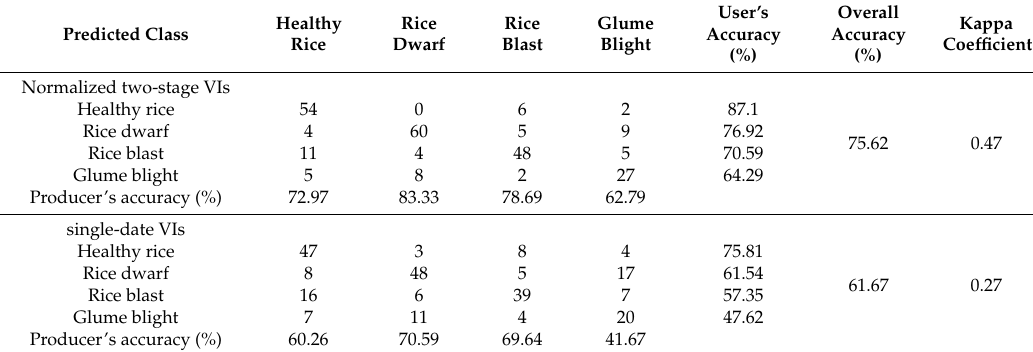
Table 5. The confusion matrices and classification accuracies produced by normalized two-stage VIs and single-date VIs with the PLS-DA method.